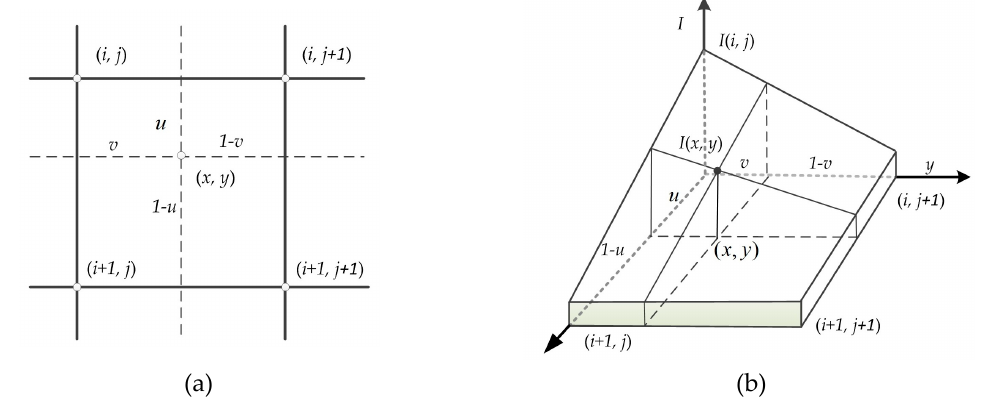
Figure 2. The architecture for the bilinear interpolation. ( a ) Distributions of the four nearest neighbor pixels and ( b ) 3D spatial distribution of the bilinear interpolation.